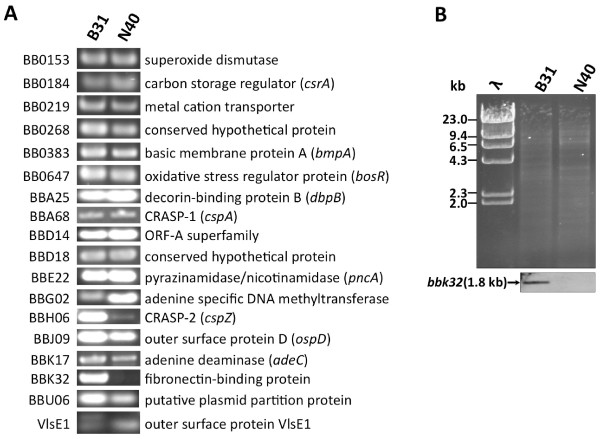
 The gene homologous to the bbk32 was not detected in N40D10/E9 strain by PCR and Southern hybridization. (A). Using the primers in Additional Table
1, complete genes bb0153, bb0184 (csrA), bb0219, bb0268, bb0383 (bmpA), bb0647 (bosR), bba25 (dbpB), bba68 (cspA), bbd14, bbd18, bbe22 (pncA), bbg02, bbh06 (cspZ), bbj09 (ospD), bbk17 (adeC), bbu06, and partial vlsE1 gene (using internal conserved primers) were amplified by PCR using B31 and N40D10/E9 strains genomic DNA as template. The bbk32 gene was amplified from B31 genomic DNA, however, PCR product was not detected in the N40D10/E9 strain. (B) Southern blot of EcoR1-digested genomic DNA of both strains (top) was hybridized with the probe prepared using the bbk32 PCR product from B31. An approximately 1.8 kb size fragment was detected only in B31, as expected, but not in the N40D10/E9 genomic DNA containing lane.